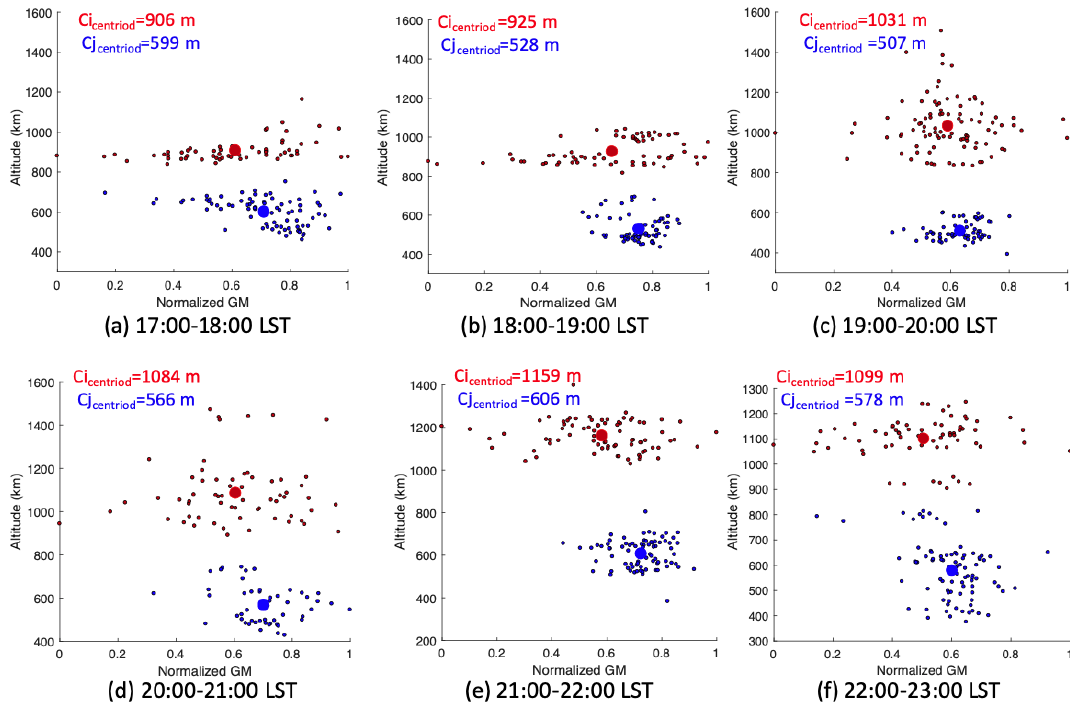
Figure 13. Distribution of altitude and the normalized gradient method (GM) value during 16:00–23:00LST.